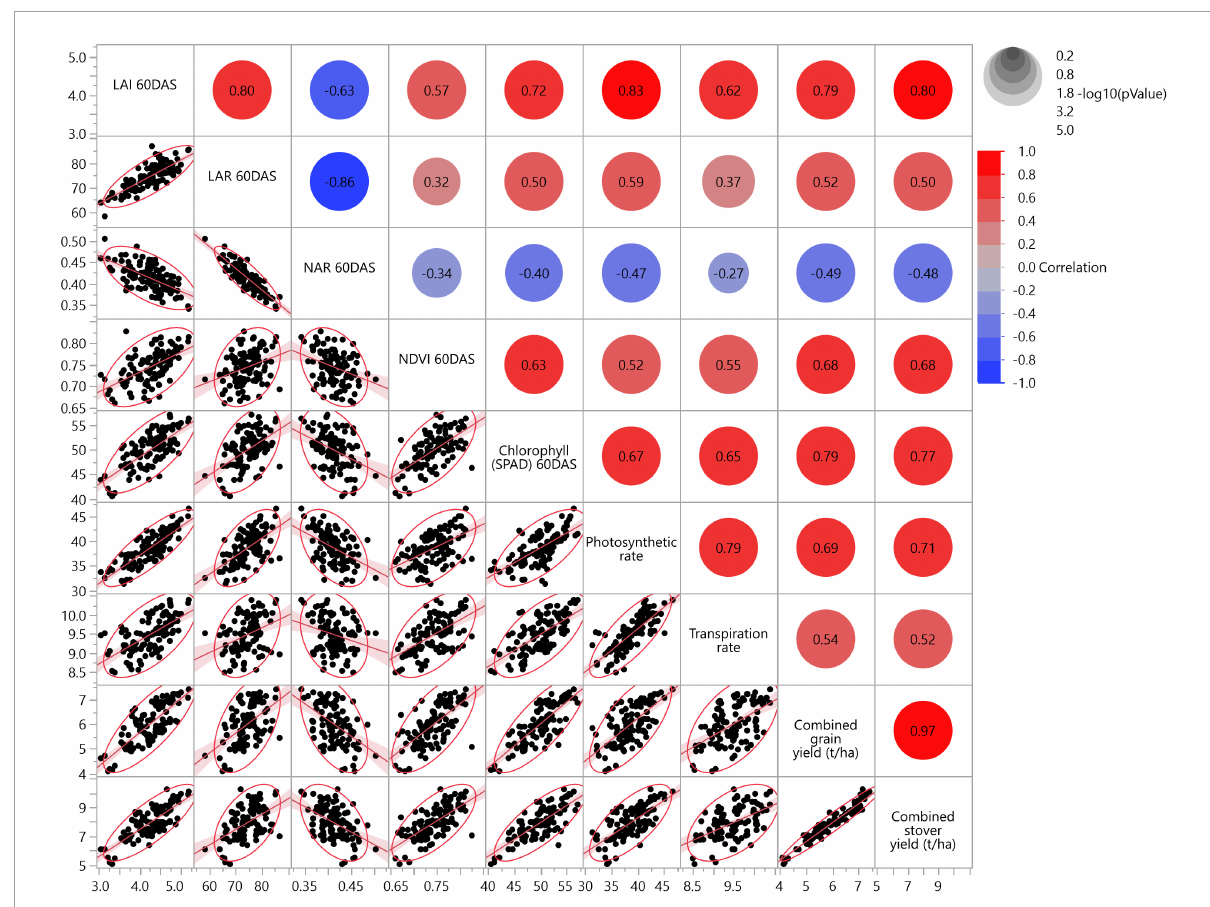
FIGURE5 Multivariate analysis showing correlation among various crop physiological (LAI, LAR, NAR, NDVI and SPAD at 60 DAS) and photosynthetic characteristics (flowering stage, 60 DAS), MEGY and MESY in maize from two cropping seasons (2019 and 2020). The lower triangle shows scatter plot matrix with line fit, and the upper triangle shows the significant circles with correlation coefficient ( p < 0.05) (2 years’ pooled